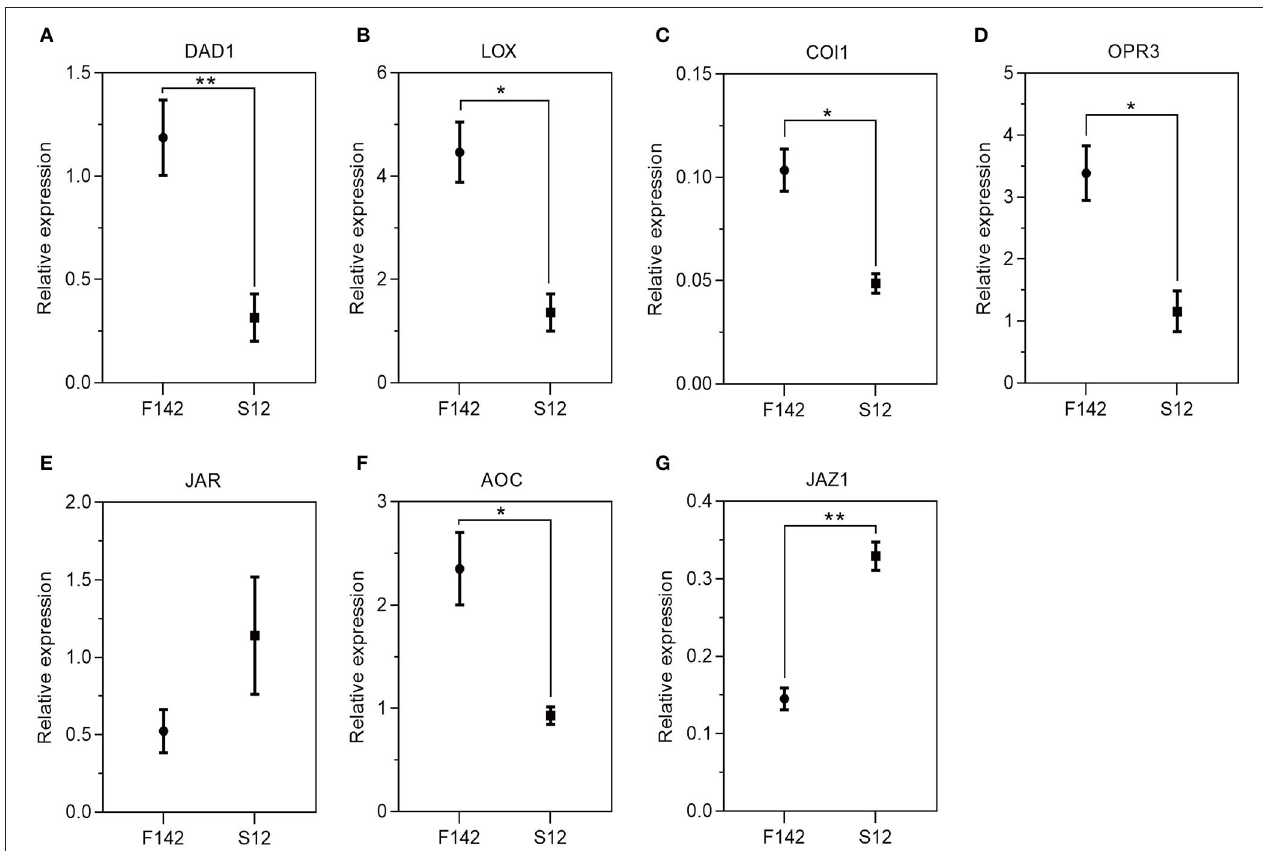
FIGURE 5 | The transcript accumulation of (A) SmDAD1 , (B) SmLOX , (C) SmCOI1 , (D) SmOPR3 , (E) SmJAR1 , (F) SmAOC , and (G) SmJAZ1 . Total RNA was extracted in anthers and used for RT-q PCR analyses. Three biological replicates (each including three technical repeats) were assessed. Paired t -tests, * p < 0.05, ** p <